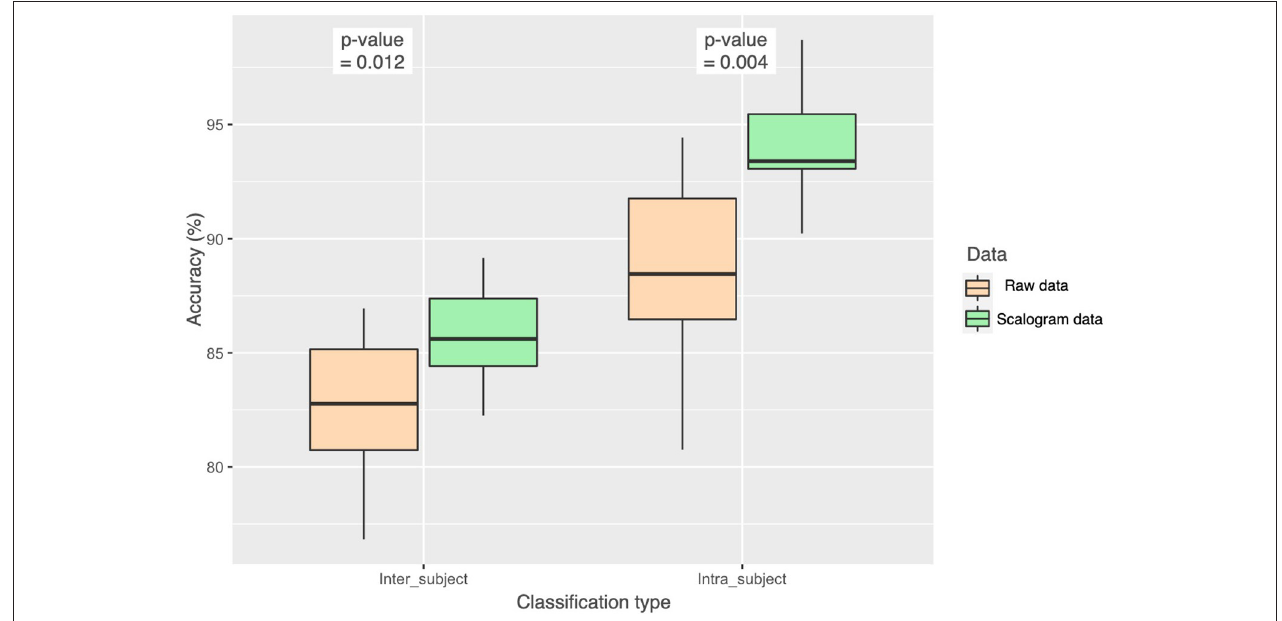
FIGURE 8 | Statistical analysis (ANOVA) of the accuracy achieved from the two approaches, using raw data and using scalogram of raw data, with the p -value for both inter-subject and intra-subject